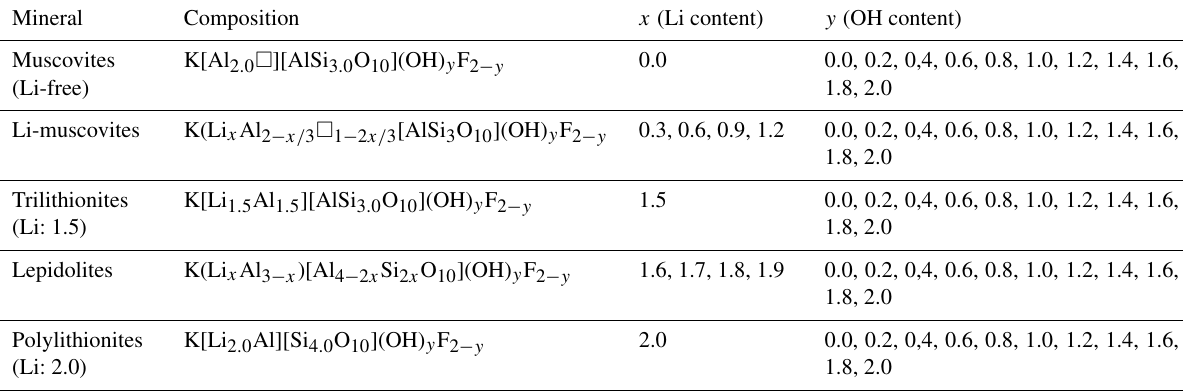
Table 1. The nominal chemical composition of the synthesis products with variable OH / F content. Mineral Composition x (Li content) y (OH content)